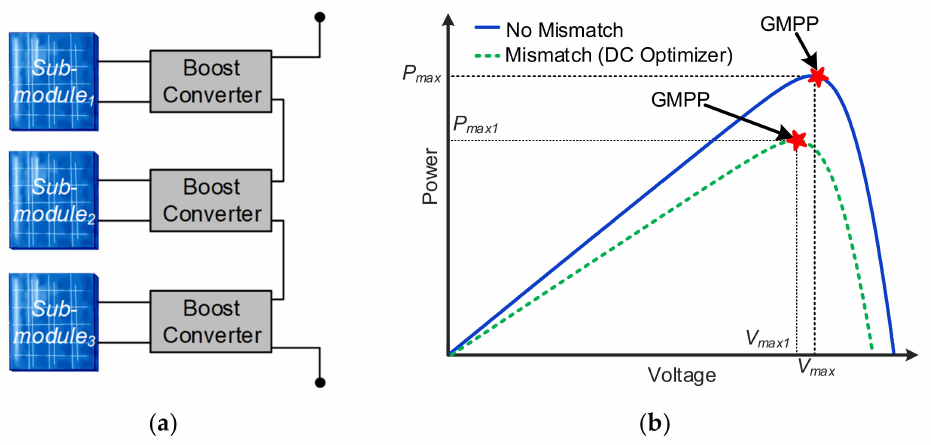
Figure 5. Solar PV module with three bypass diodes: ( a ) no shading, ( b ) sub-module 1 shaded, and ( c ) power-voltage (P-V) characteristic curve under mismatch.